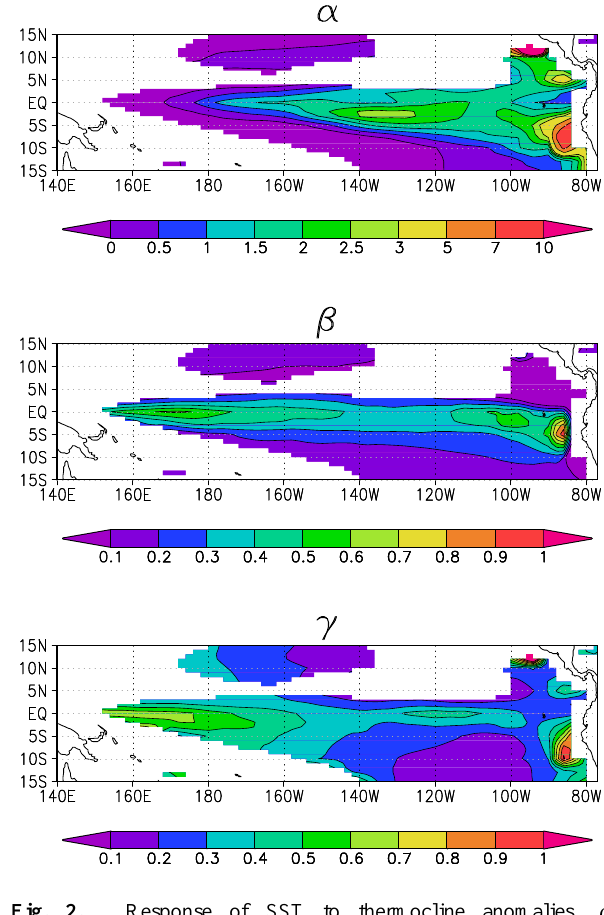
Fig. 2. Response of SST to thermocline anomalies, α [0 . 1Km − 1 month − 1 ] (top) and to wind stress anomalies, β [100KPa − 1 month − 1 ] (middle) and the damping time on SST, γ [month − 1 ] (bottom) for the STAM member. Only areas in which the SST-equation (Eq. 1) describes more than 40% of the SST vari- ability are shaded. Note the nonlinear colour scale in the response of SST to thermocline anomalies.